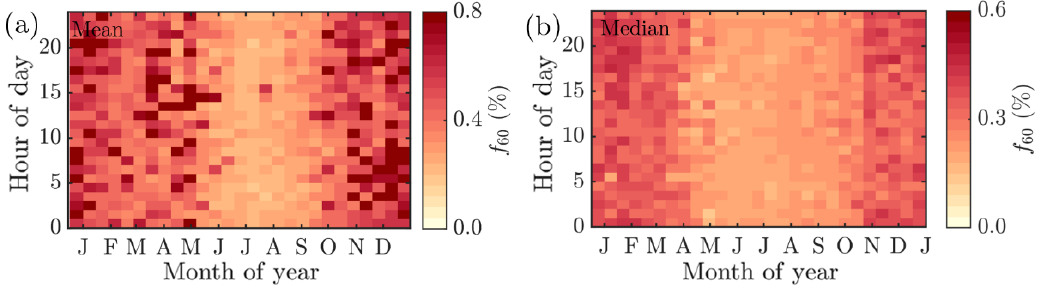
Figure A4. The mean (a) and median (b) f 60 (the fraction of m/Q 60 Th signal of the total OA signal) values derived from the ACSM measurements (2012–2018 at SMEAR II). The x axes represent the time of the year and the y axes the hour of the day (UTC + 2). The colored pixels represent the f 60 values. Note the different color scales between the mean and median figures. It is also worth mentioning that due to the rather low signal to noise ratio of the ACSM, the f 60 estimates can be very noisy. To avoid the weight of the high and low noise extremes in (a) (mean f 60 ), only the range of 0 ≥ f 60 ≤ 1 were included in the f 60 mean field calculation.